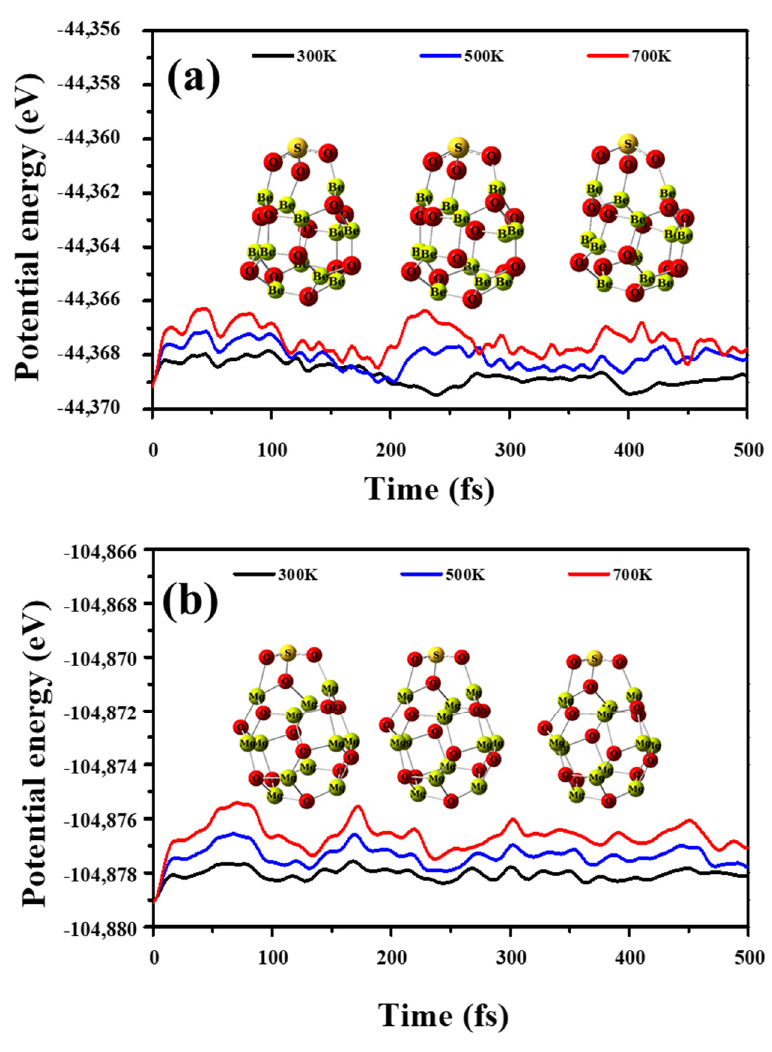
Figure 10. Potential energy fluctuations during MD simulation for ( a ) SO 2 /Be 12 O 12 , and ( b ) SO 2 /Mg 12 O 12 and the atomic configuration after 500 fs at 300, 500, and 700 K.